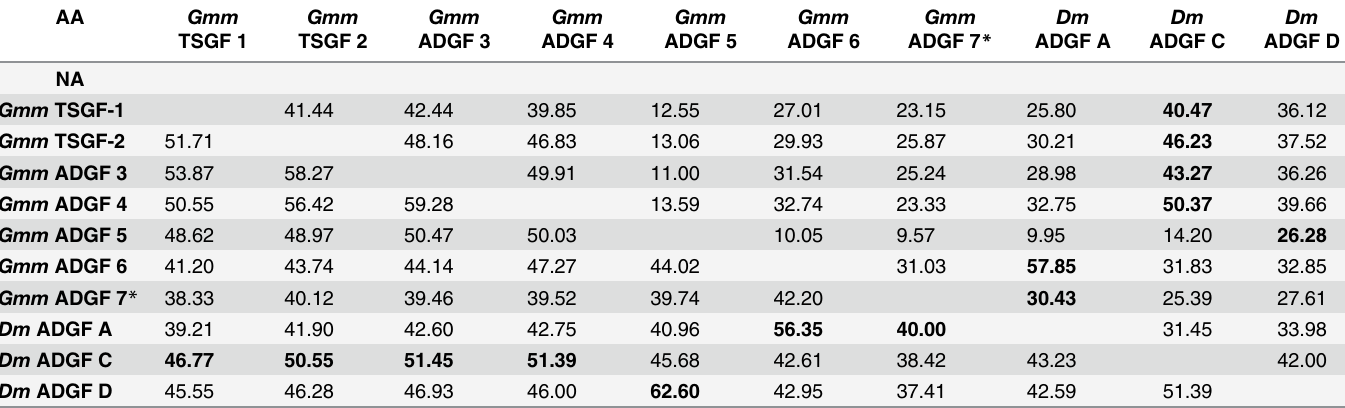
Note: Bold characters indicating the highest identity of TSGF with Dm ADGF sequences. * : TSGF7 have a stop codon in 607 – 609 bp. Here the protein sequence included in the comparison is only 202 aa. But the nucleotide sequence is the whole transcripts corresponding to the ORF sequence of other TSGF and ADGFs in